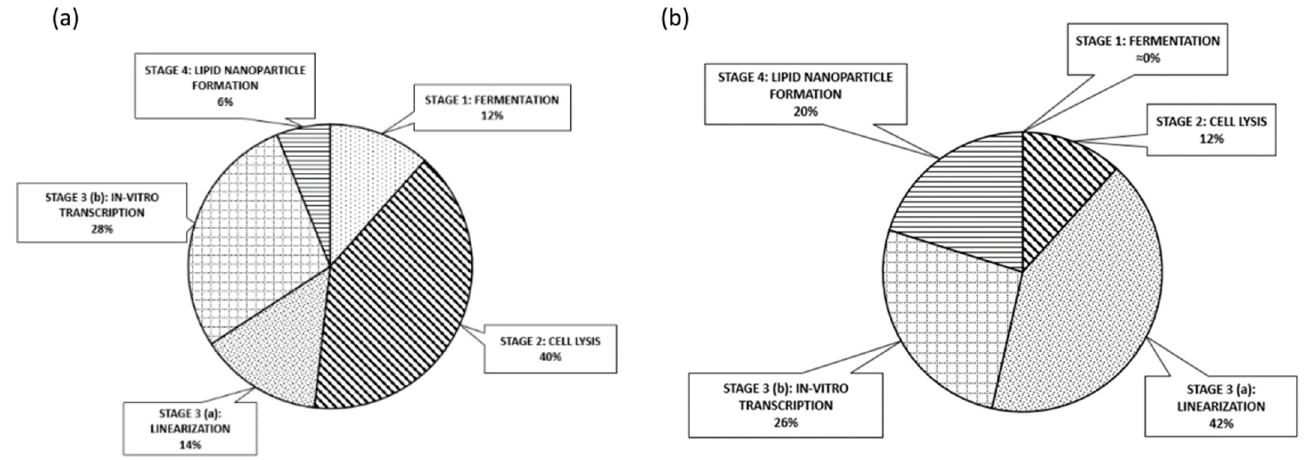
Figure 10. Percentile contributions to the overall cost (pies) of continuous GMP mRNA formulated products by lipoparticle carriers: ( a ) equipment; ( b ) raw material.